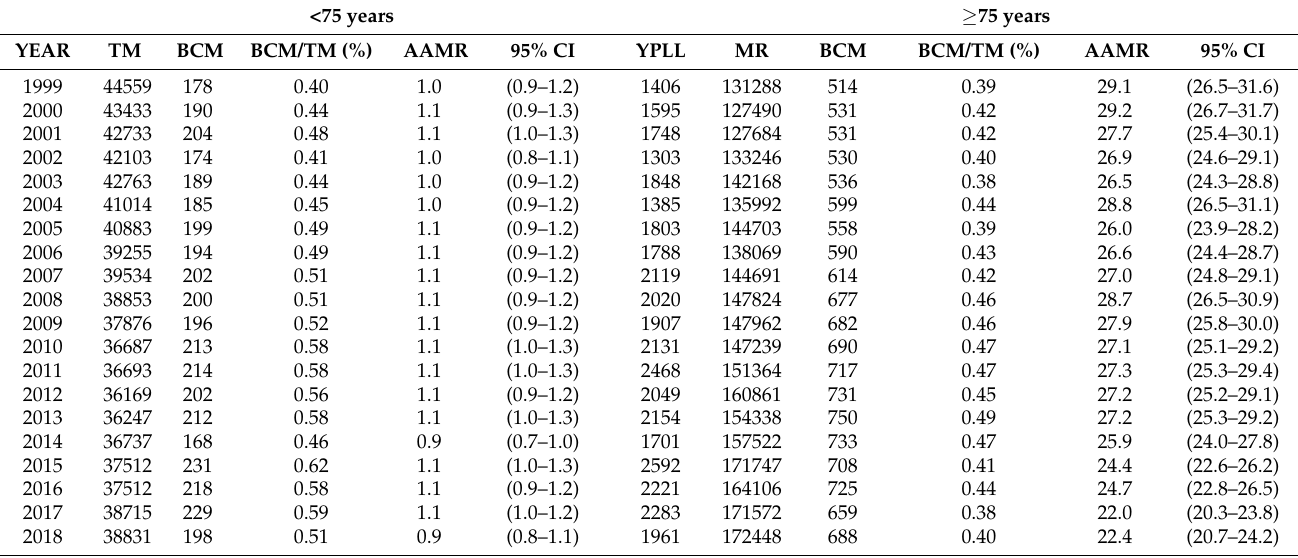
Table 2. Total mortality, mortality due to BC, proportional mortality, AAMRs related to BC per 100,000 inhabitants and YPLL by age group in women in Spain during the period 1999–2018. TM: total mortality; BCM: bladder cancer mortality; AAMR: age-adjusted mortality rate per 100,000 inhabitants (direct method, European standard population of 2013); 95% CI: 95% Confidence Interval; YPLL: years of potential life